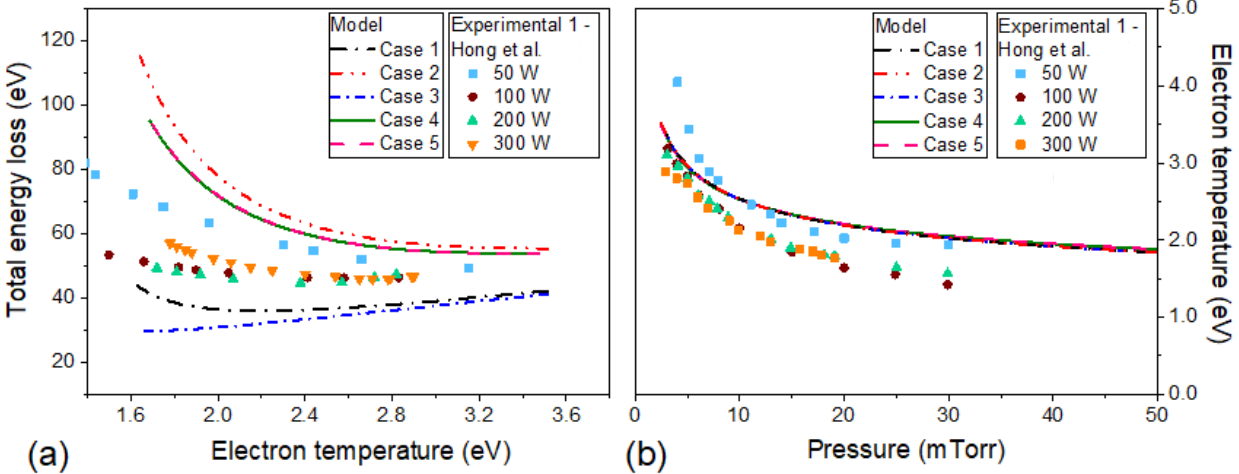
Figure 7. The total energy loss as a function of electron temperature ( a ) and electron temperature as a function of gas pressure ( b ) for the 5 cases studied. The model results are the same for all absorbed power values in the simulated range (50 W a 600 W). The data points are relative to experimental data at different absorbed power of Hong et al. [29]. The simulations (lines) were performed with the input parameters: R = 13 cm, L = 12 cm, T g = 300 K and Q = 50 sccm.